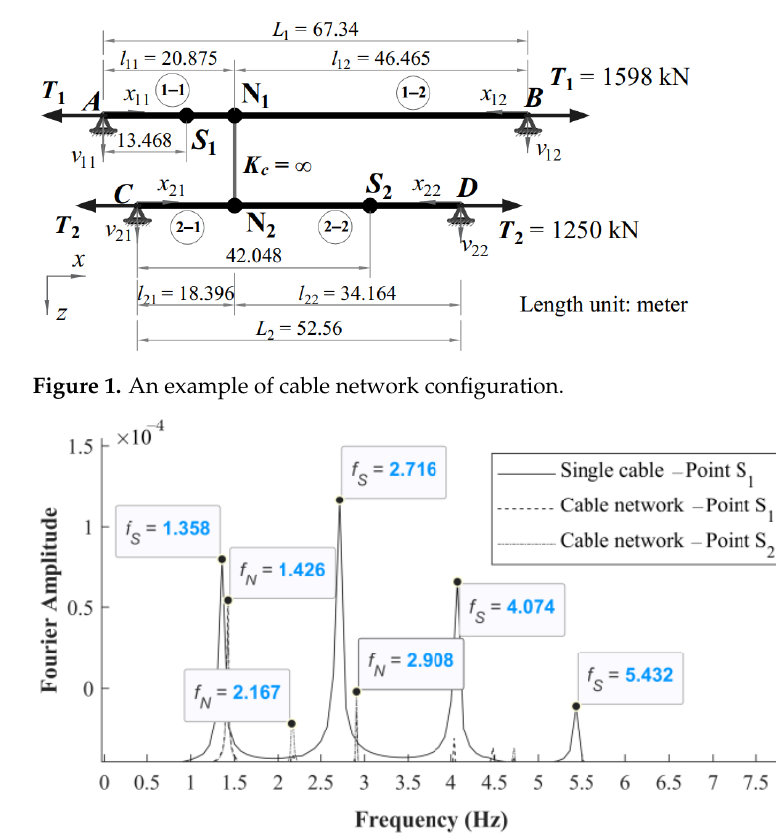
Figure 2. Comparison of modal frequency spectrum between network cable and single cable.